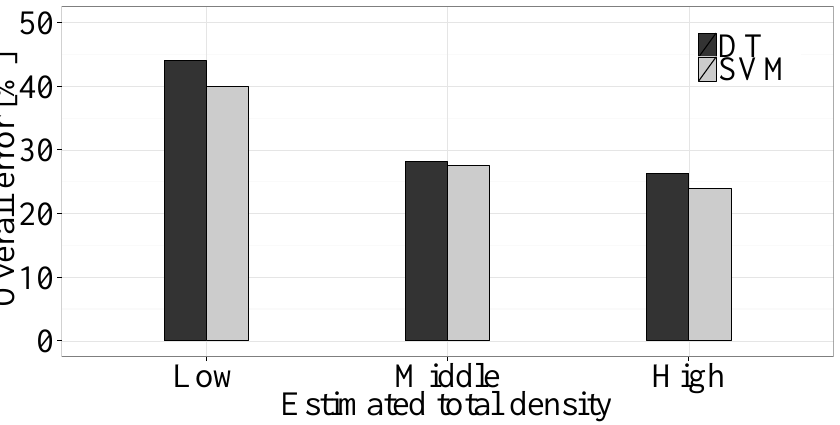
Figure 5. Vegetation density influence on the overall error of the DT and the